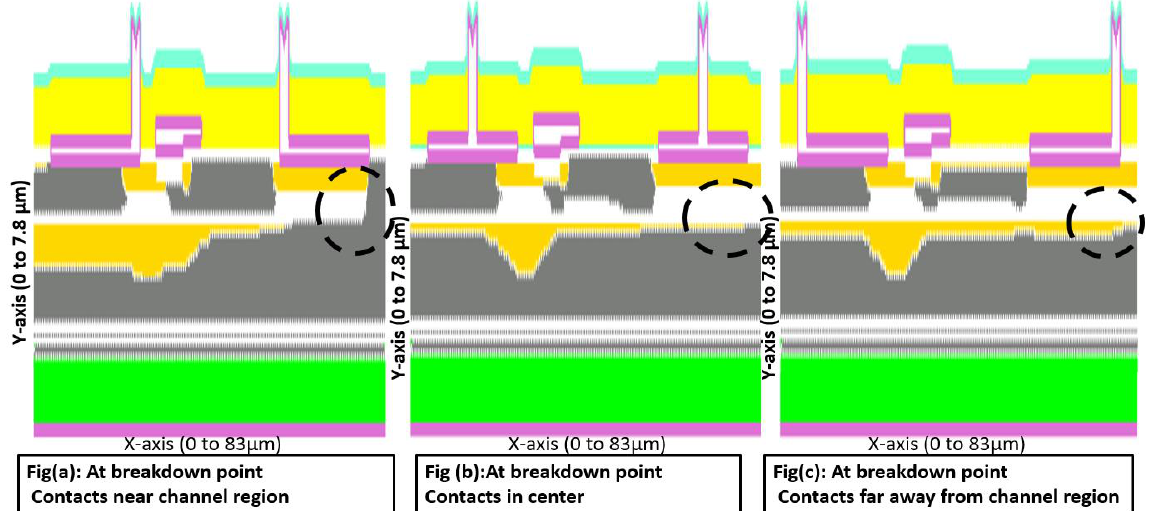
Figure 8. Depletion pattern with different metal positions.